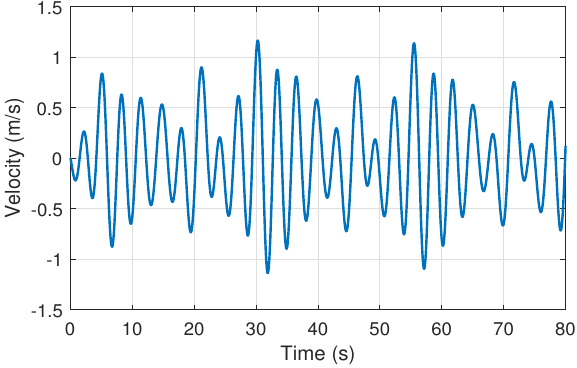
Figure 4. Velocity of the structure without